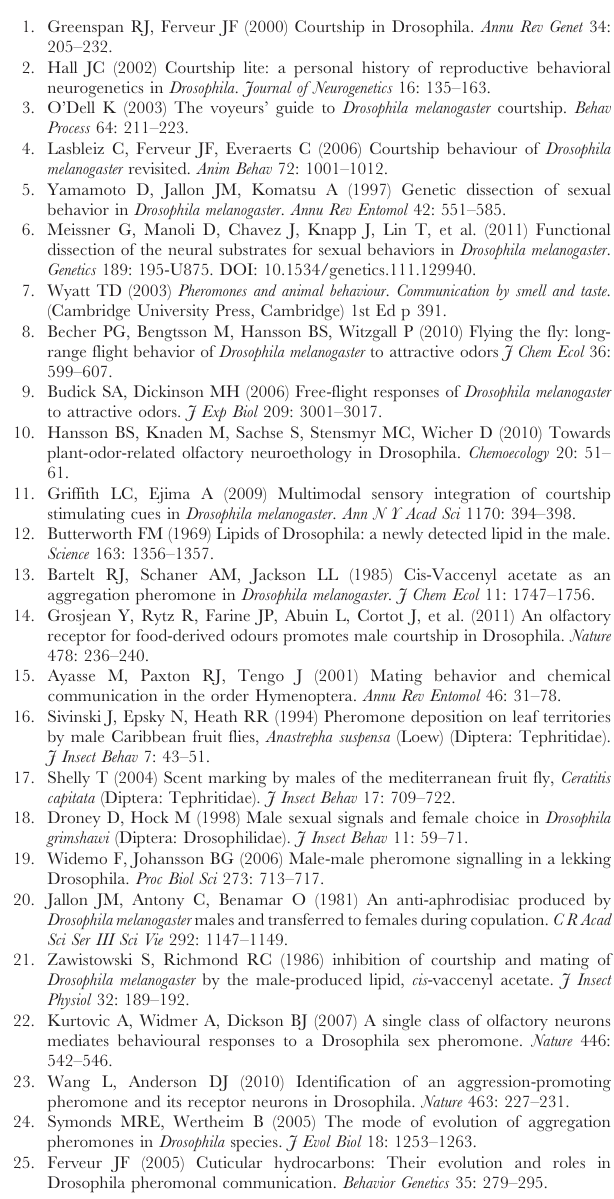
F) and in groups of 5 and 10 heterosexual pairs (SPx5 and SPx10, respectively). The amounts are expressed in ng/individual as the mean (SEM or range). Letters indicate significant differences (Kruskal-Wallis test). For compound names, see Table1. n = 5 6 10 or 20 individuals. Table S1 Amount of all compounds and of # n-C23 compounds in body, deposited and volatile CH fractions from 5-day-old S- and G-flies grouped in same-sex groups of 10 individuals for a two hour ‘‘socialization’’ period in a small 15 ml vial (Sg- and Gg-flies). The amounts are expressed as the mean (SEM or range) in units of ng/ individual. Letters indicate significant differences (Kruskal-Wallis test, p = 0.05). 1 : As volatile fractions consisted of only # n- C23 compounds, their amount values were tested only once.